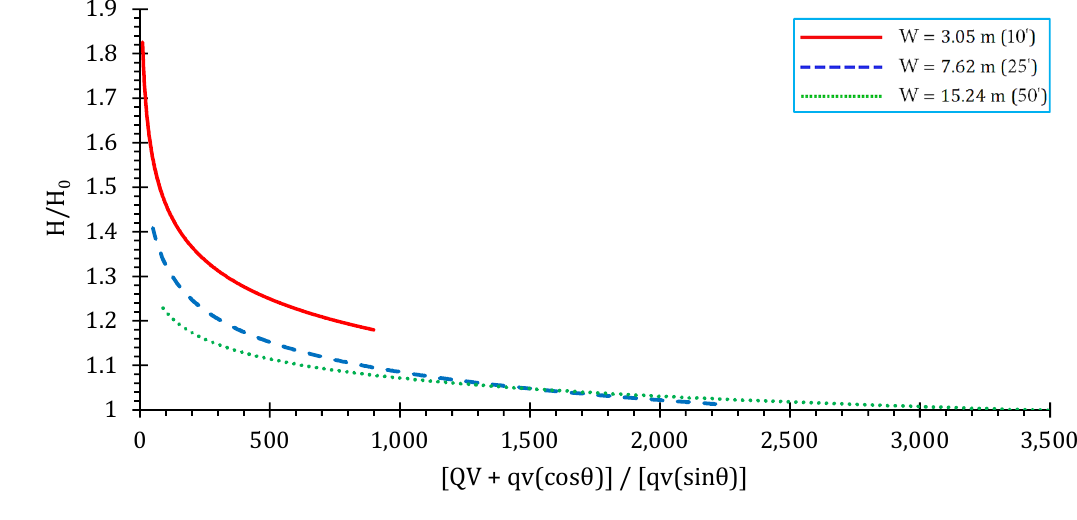
Figure 33. Conservative design curves for Fr = 0.8 in the channel.